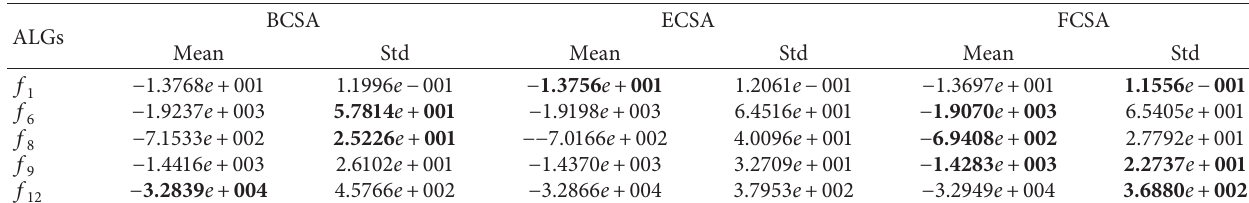
Table 6: Results of BCSA, ECSA, and FCSA when D � 100.